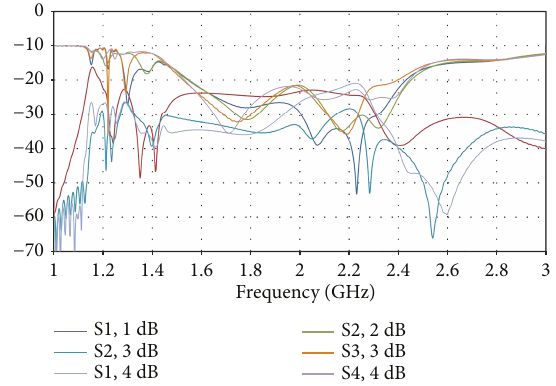
Figure 7: S -parameter simulation of a four-antenna array structure.